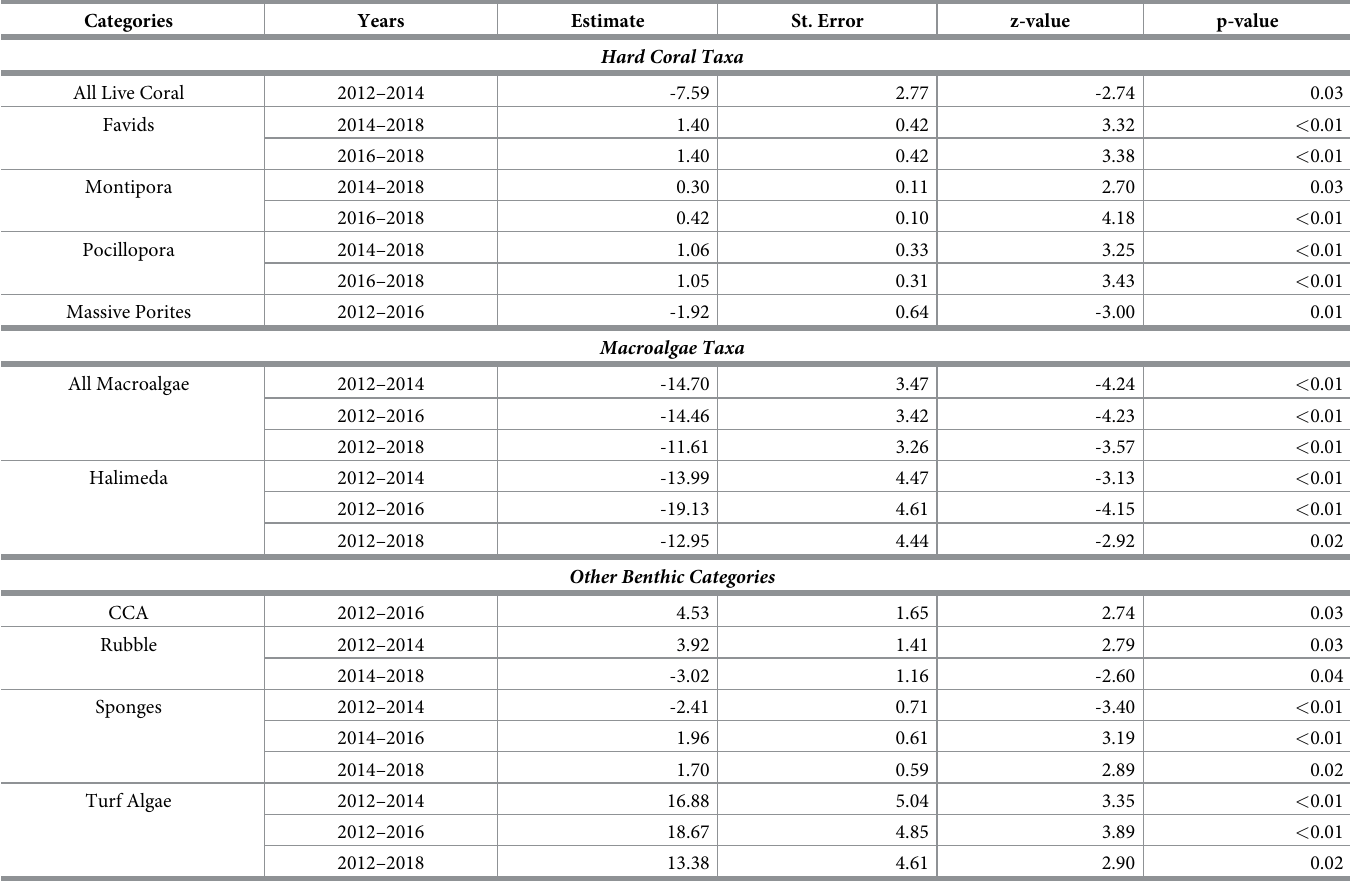
Table 3. Significant results of Tukey contrasts multiple comparisons of means for changes in percent cover, using α = 0.05. Categories